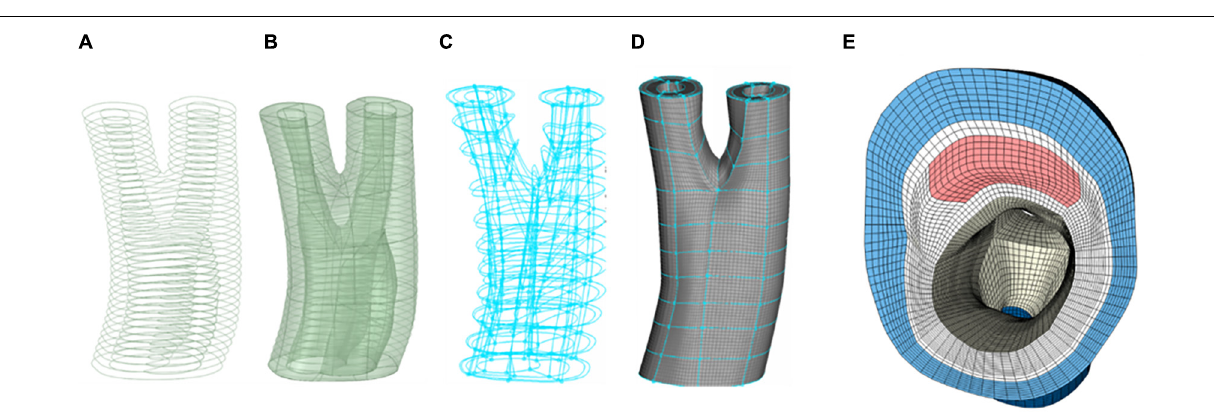
FIGURE 3 | Different stages of meshing a diseased carotid with plaque atheroma and lipid pool. (A) Contours of the different components of the arterial wall. (B) Constructing and smoothing the inner and outer surfaces. (C) The connectivity of the boxes associated with each component of the vessel wall. (D) Hexahedral meshing of the boxes. (E) A cross section of the common carotid artery indicating the components in the vessel wall and quality of the mesh at the apex of the